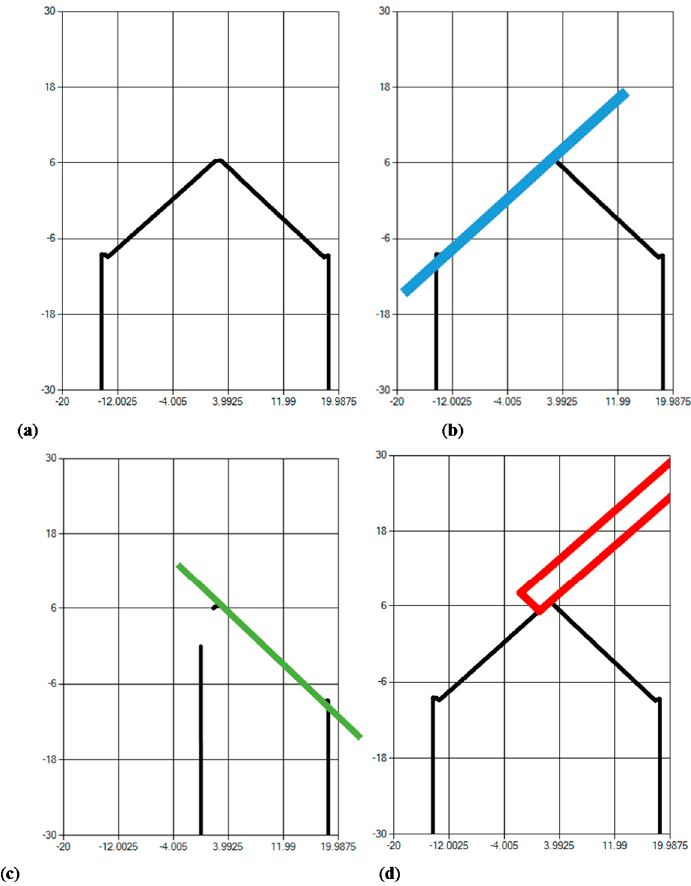
Figure 13. Cross − sectional contour information of the workpiece cutting edges (the blue and green lines shows the contour fitting result, and the red box is the schematic of deburring tool): ( a ) contour information, ( b ) fitting of first line segment, ( c ) fitting of second line segment, and ( d ) cutter trajec- tory.